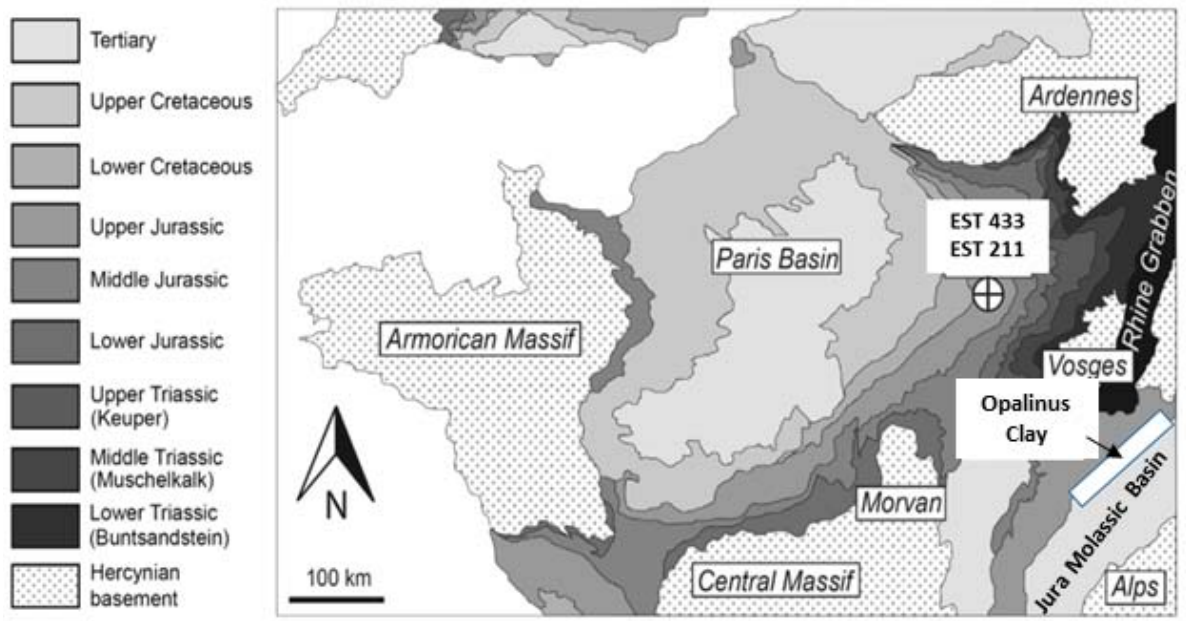
Figure 3. The Paris Basin, showing the locations of Boreholes EST433 and EST211. The white rectangle frames the location of boreholes where Opalinus Clay was sampled.